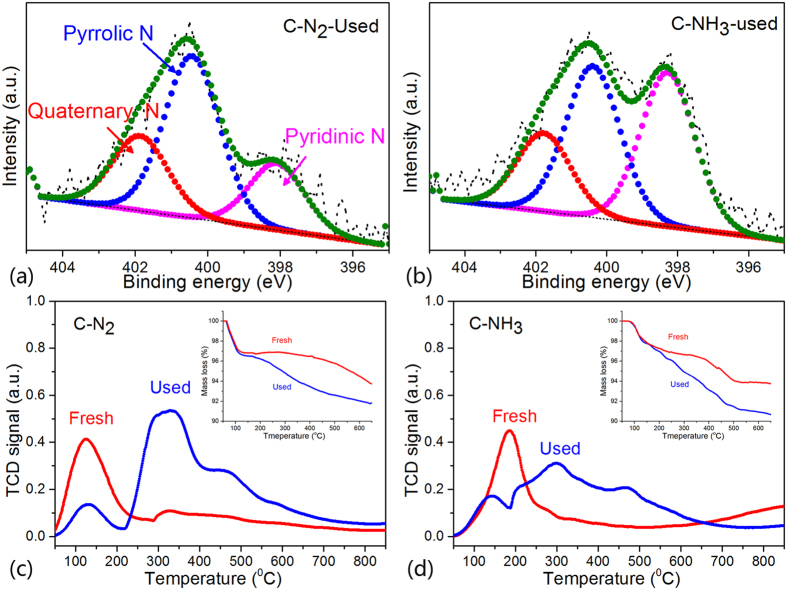
(a) and (b) N 1 s XPS of used C-N2 and C-NH3. (c) and (d) C2H2–TPD and (b) TG analysis of used C-N2 and C-NH3.